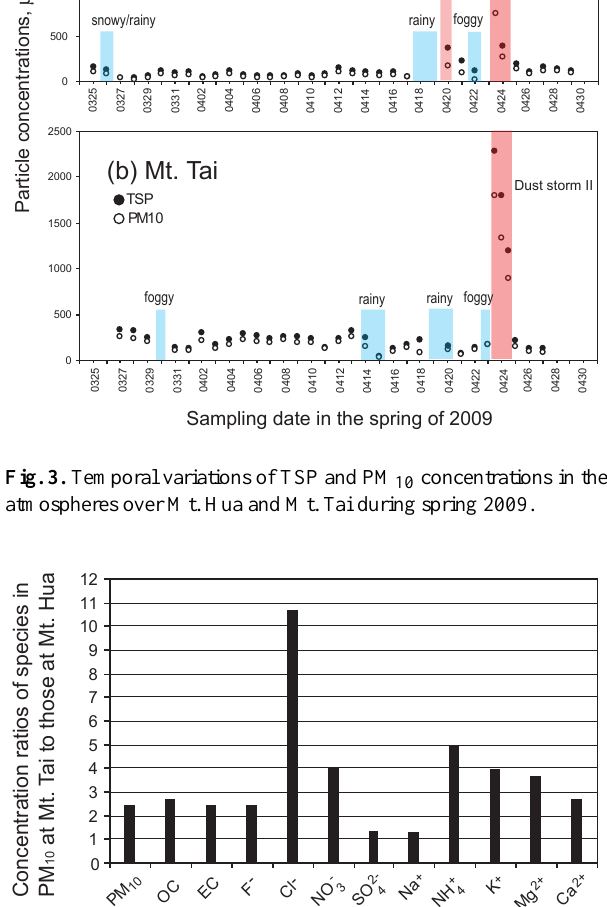
Figure 4. Difference in the concentraitions of species in PM10 between Mt. Hua and Mt. Tai during the non-dust storm period in spring 2009